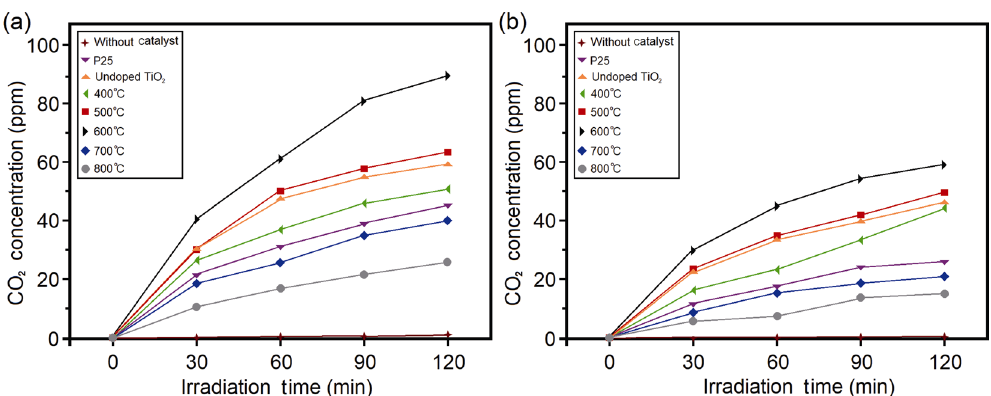
Fig. 9 Photogeneration of CO 2 from RhB solution without catalyst material, and by using reference P25, undoped TiO 2 nanorod, and N–Fe codoped TiO 2 nanorods annealed at different temperatures under (a) UV light irradiation and (b) visible-light